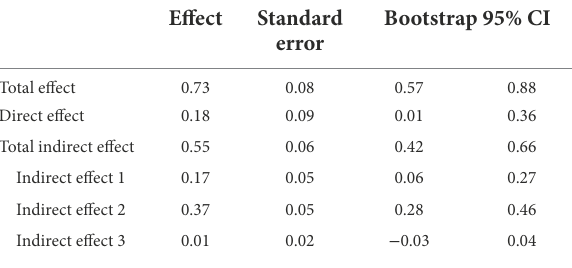
TABLE 5 Direct and direct effects of job satisfaction on job